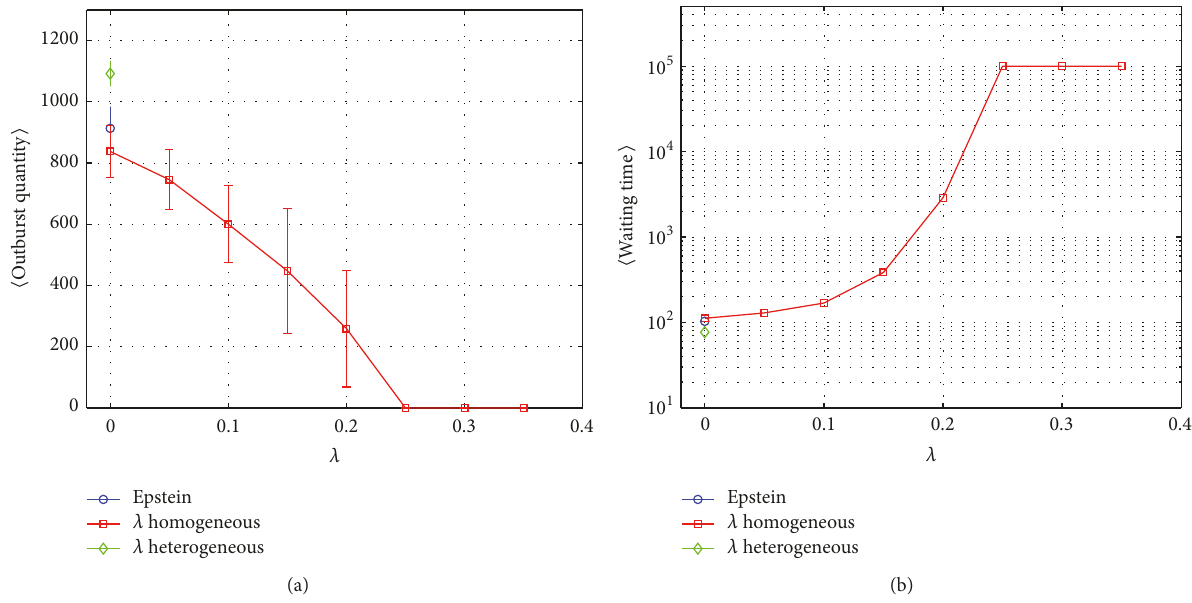
Figure 7: (a) The outburst quantity and (b) the waiting times are shown as a function of the saving parameter with the rescaled legitimacy. The line with red squares shows the time between each outburst for homogeneous 𝜆 . The blue circle corresponds to the value obtained with the Epstein model and the green diamond corresponds to the value obtained for the case with heterogeneous